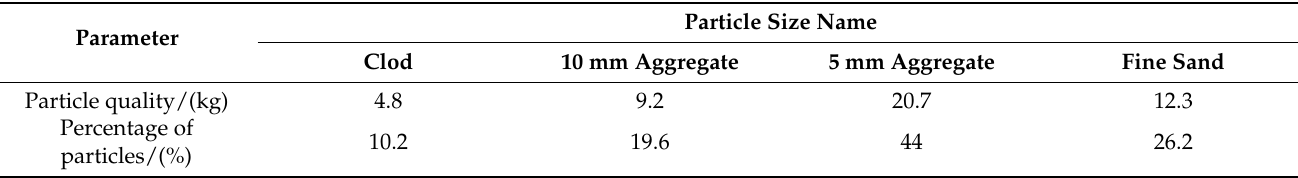
Table 4. Soil particle